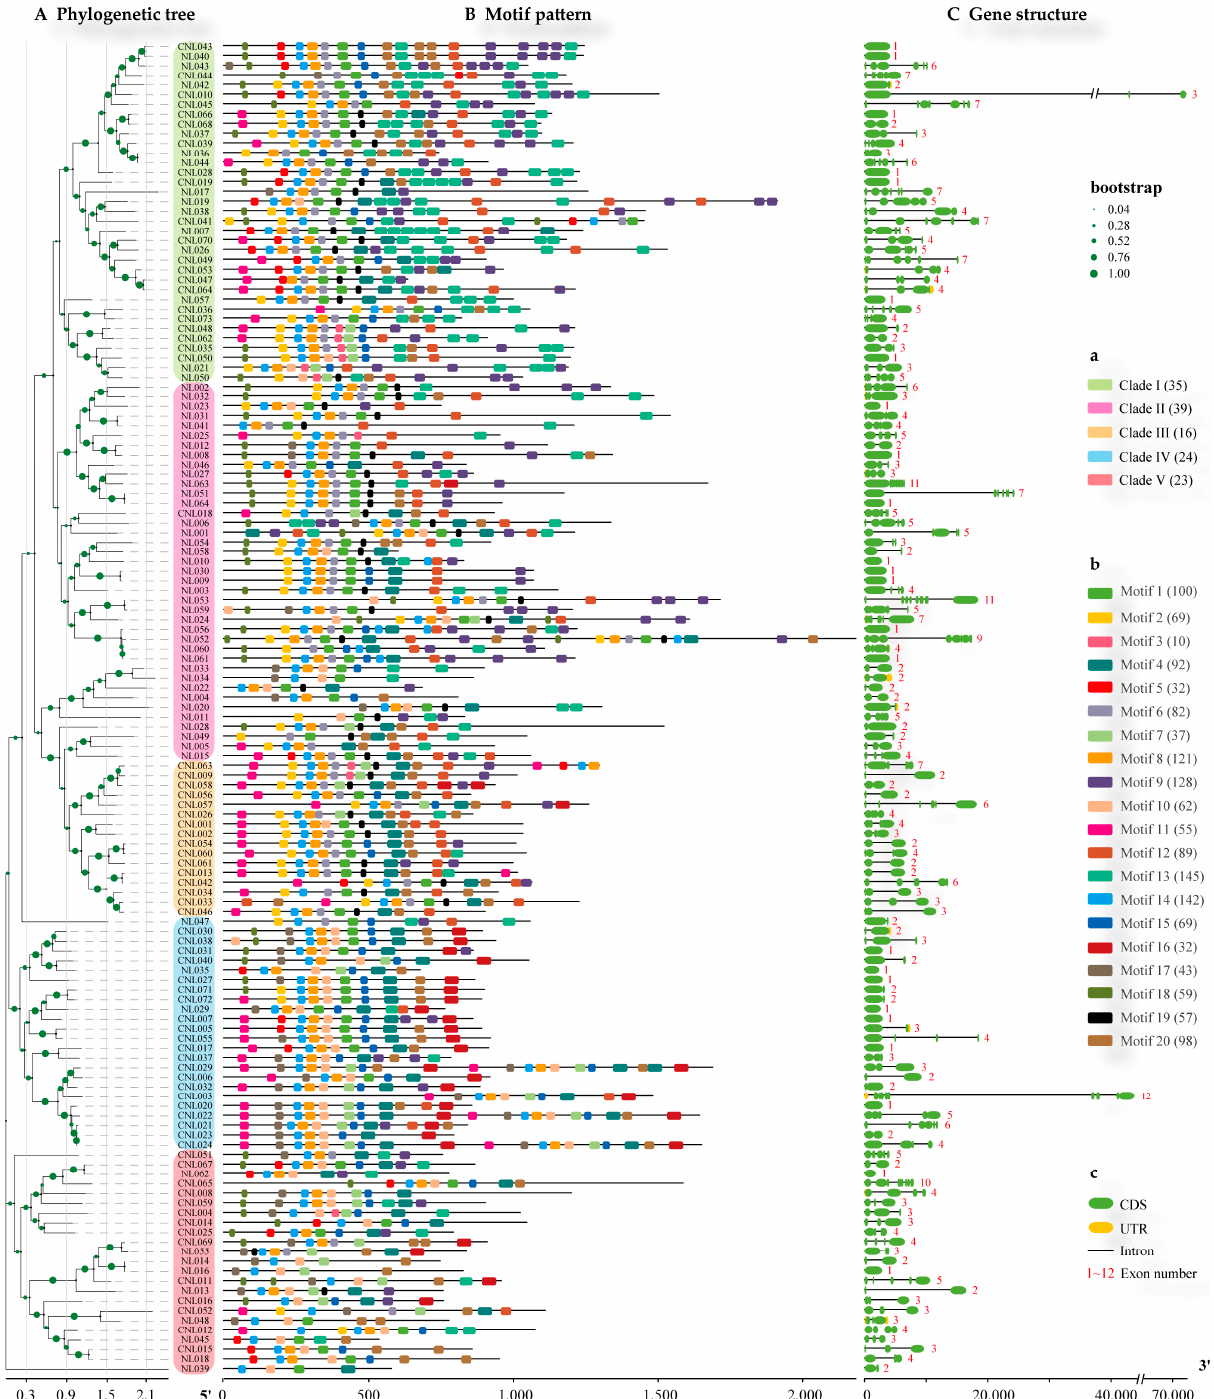
Figure 3. Phylogenetic relationships, gene structure, and architecture of conserved protein motifs in NLR genes from Saccharum spontaneum . ( A ) The phylogenetic tree was constructed based on the NBS sequences of 137 CNL and NL-type proteins from S. spontaneum using MEGA X. Five clades of I, II, III, IV, and V are marked in different colors. ( B ) The motif composition of S. spontaneum NLR proteins. The motifs 1-20 are marked with different colors. ( C ) Structure of S. spontaneum NLR genes. Yellow boxes represent untranslated 5 ′ - and 3 ′ -UTRs; green boxes represent CDSs; black lines represent introns. The length of proteins and genes can be measured using the scale at the bottom.